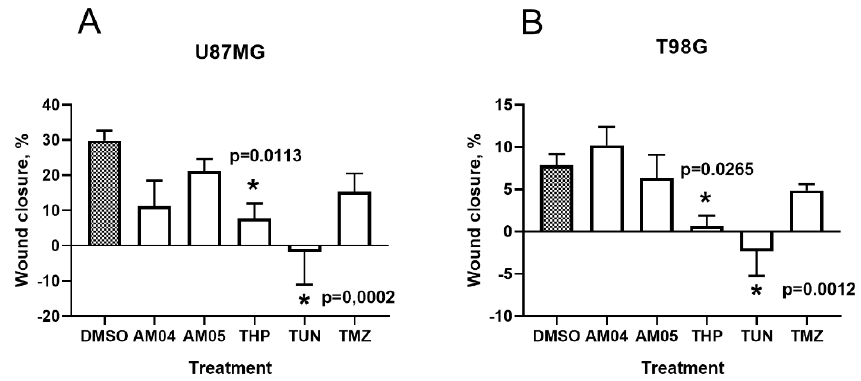
Figure 4. Percentage of wound closure of U87MG ( A ) and T98G ( B ) cells after the di ff erent treatments were analyzed by the wound healing assay compared to untreated control (DMSO). AM04 (0.55 and 1.10 µ M for T98G and U87MG, respectively); AM05 (0.83 and 1.66 µ M for T98G and U87MG, respectively) and 2.05 µ M THP, 0.5 mM TMZ and 8 µ g / mL TUN for both cell